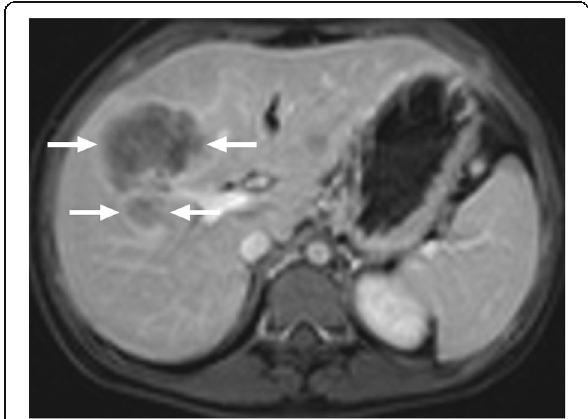
Fig. 11 A 16-year-old girl with known surgically treated Wilms tumor undergoing MRI evaluation for newly detected hypoechoic liver mass on US. Axial plane postcontrast T1W MR image demonstrates two peripherally enhancing lesions (arrows) in the right liver lobe. Post percutaneous biopsy showed fascioliasis with no evidence of malignant cells